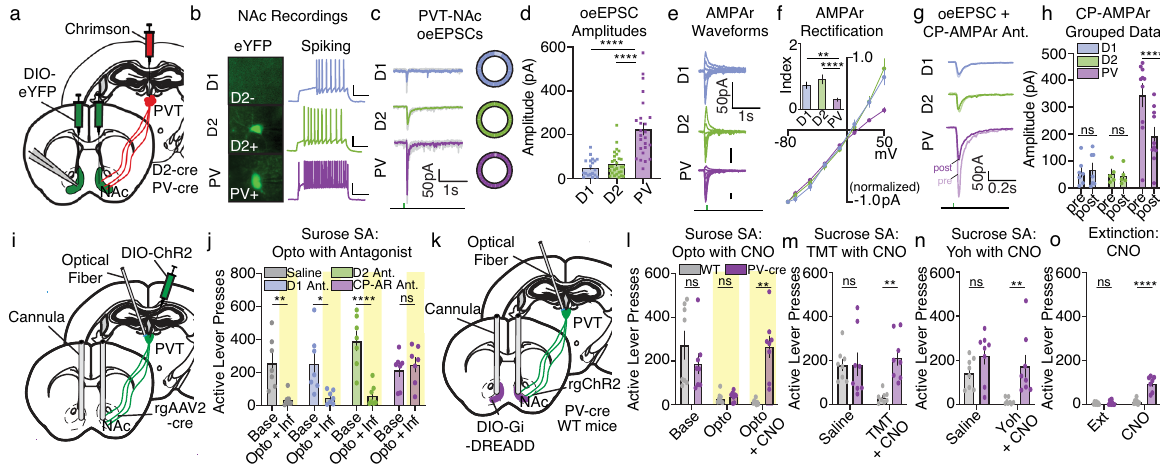
Fig. 3 | PVT → NAc-dependent suppression of sucrose seeking requires down- stream CP-AMPArs and PV interneurons. a Surgery for slice electrophysiology. b Example fl uorescent images (left) and current-clamp traces (right) for NAc cell types(scale:25mV/0.2s). c , d Examplewaveforms( c ;piechartsshowproportionof light-responding neurons) and grouped data ( d ) reveal elevated oeEPSC ampli- tudes in NAc PV-INs (D1-MSNs: n =19 cells, 8 mice; D2-MSNs: n =28 cells, 11 mice; PV-INs: n =25 cells, 9 mice; one-way ANOVA, F 2,69 =27.78, P <0.001; Sidak ’ s post- hoc: PV-INs vs D1/D2-MSNs P -values<0.001). e , f Example waveforms ( e ) and groupeddata ( f ) showing PVT → NAc PV-IN synapses are selectively inwardlyrectifying (D1-MSNs: n =11 cells, 5 mice; D2-MSNs: n =10 cells, 5 mice; PV-INs: n =16 cells, 7 mice). Inset: recti fi cation index (I 50 /-I − 70 ; one-way ANOVA, F 2,34 =13.27, P <0.001; Sidak ’ s post-hoc: PV-INs vs D1/D2-MSNs P -values<0.003). g , h Waveforms ( g )